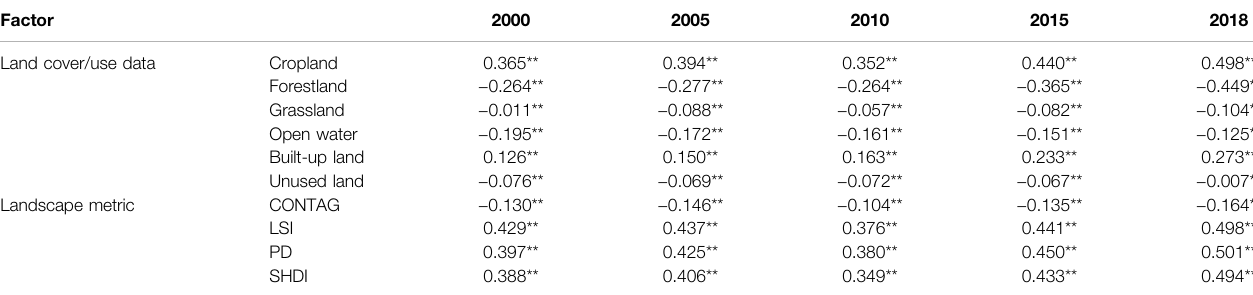
TABLE 3 | Pearson correlation coef fi cients between UHI intensity and land cover features and landscape metrics. Factor